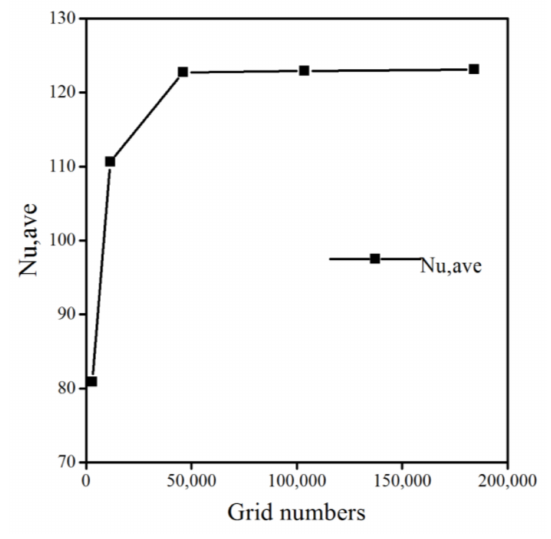
Figure 5. Grid independence